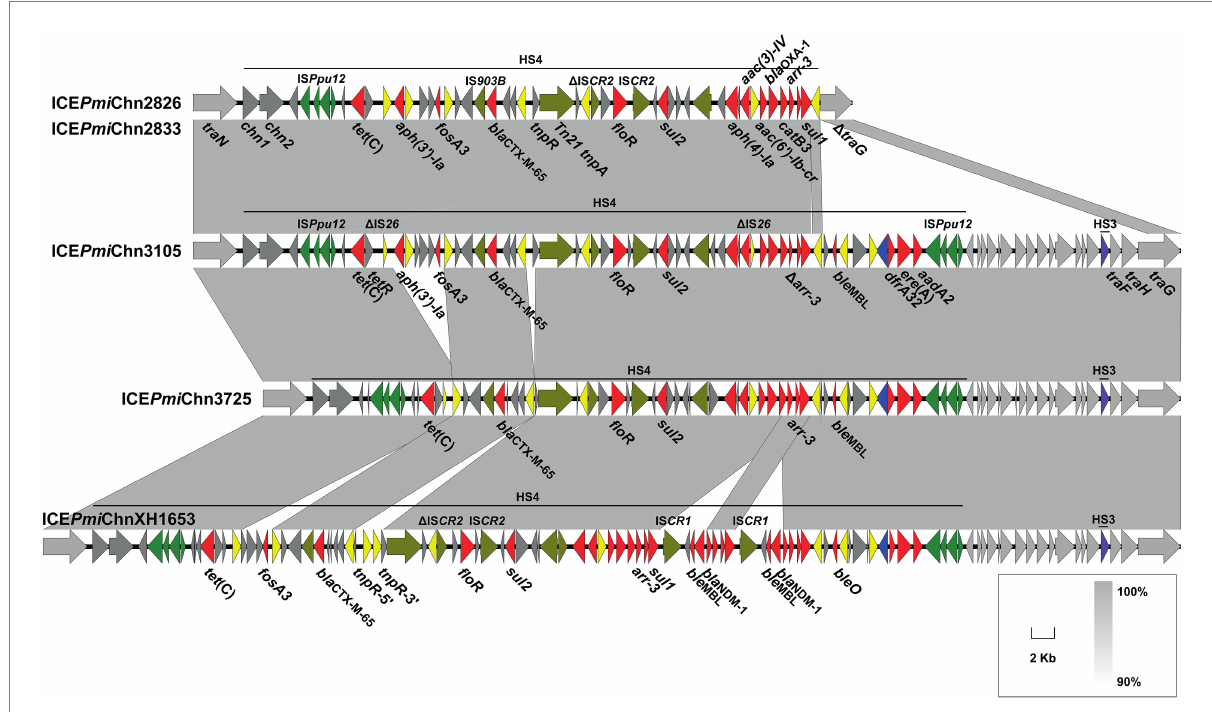
FIGURE 3 Genetic characteristics of HS4. The HS4-bearing region of ICE Pmi Chn2826 (ICE Pmi Chn2833), ICE Pmi Chn3105, and ICE Pmi Chn3725 is compared with that of ICE Pmi ChnXH1653 (accession no. CP065039). Genes are indicated by arrows, and those in HS4, HS3 and backbone are indicated in dark grey, purple and light grey, respectively. ARGs, integrase genes, IS 26 , IS Ppu12 , and other transposase genes are highlighted in red, blue, yellow, green, and olive, respectively. Shared regions of > 90% nucleotide sequence identity are indicated by grey